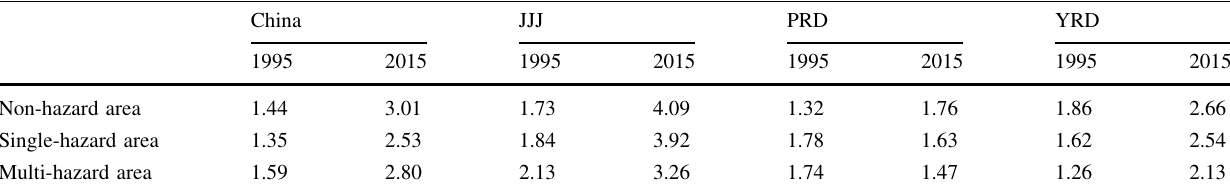
Table 7 Per capita built-up land area (hm 2 ) in different hazard-prone areas of China and three major urban agglomerations for 1995 and